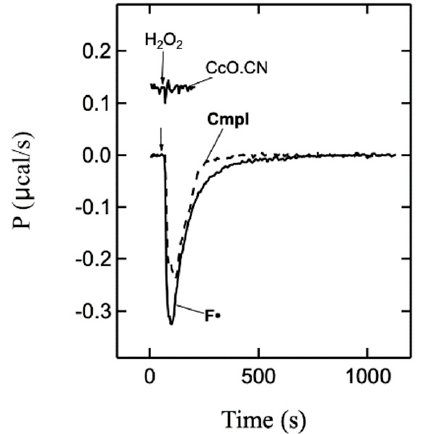
Figure 4. Heat released during the production of the F • state. The time dependence of the rate of the heat release following the injection of peroxide (5 µ M) into the reaction cell filled with 50 µ M oxidized native CcO ( F • full line), 50 µ M CN-ligated oxidized CcO ( CcO.CN line) and 5 µ M horseradish peroxidase (CmpI , dashed line) at 5 ◦ C. The arrows (H 2 O 2 ) show the time of peroxide injection. The buffer was 39 mM potassium phosphate, pH 5.7, 12.5 mM K 2 SO 4 , and superoxide dismutase (30 units/mL). The buffer with CcO samples also contained 0.6% DM.